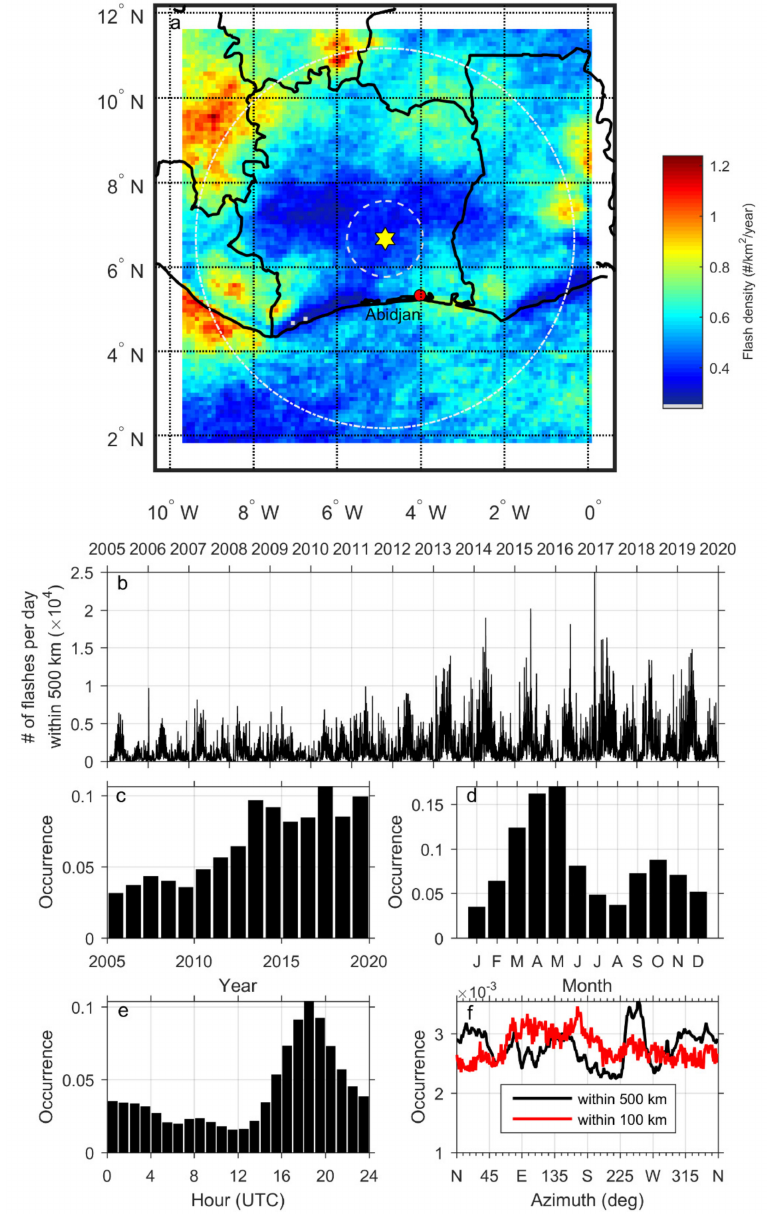
Figure 3. Lightning activity based on WWLLN data within 500 km from the IS17 station between January 2005 and December 2019. ( a ) Map of the flash density around the IS17 station (yellow star); the dashed circle defines a 100-km radius centered on the station, while the dotted-dashed circle depicts a 500-km radius. ( b – e ) Temporal distribution of flash activity within 500 km from IS17: ( b ) daily, ( c ) yearly, ( d ) monthly, and ( e ) hourly. ( f ) Azimuthal occurrence within 500 km (black curve) or within 100 km (red) from